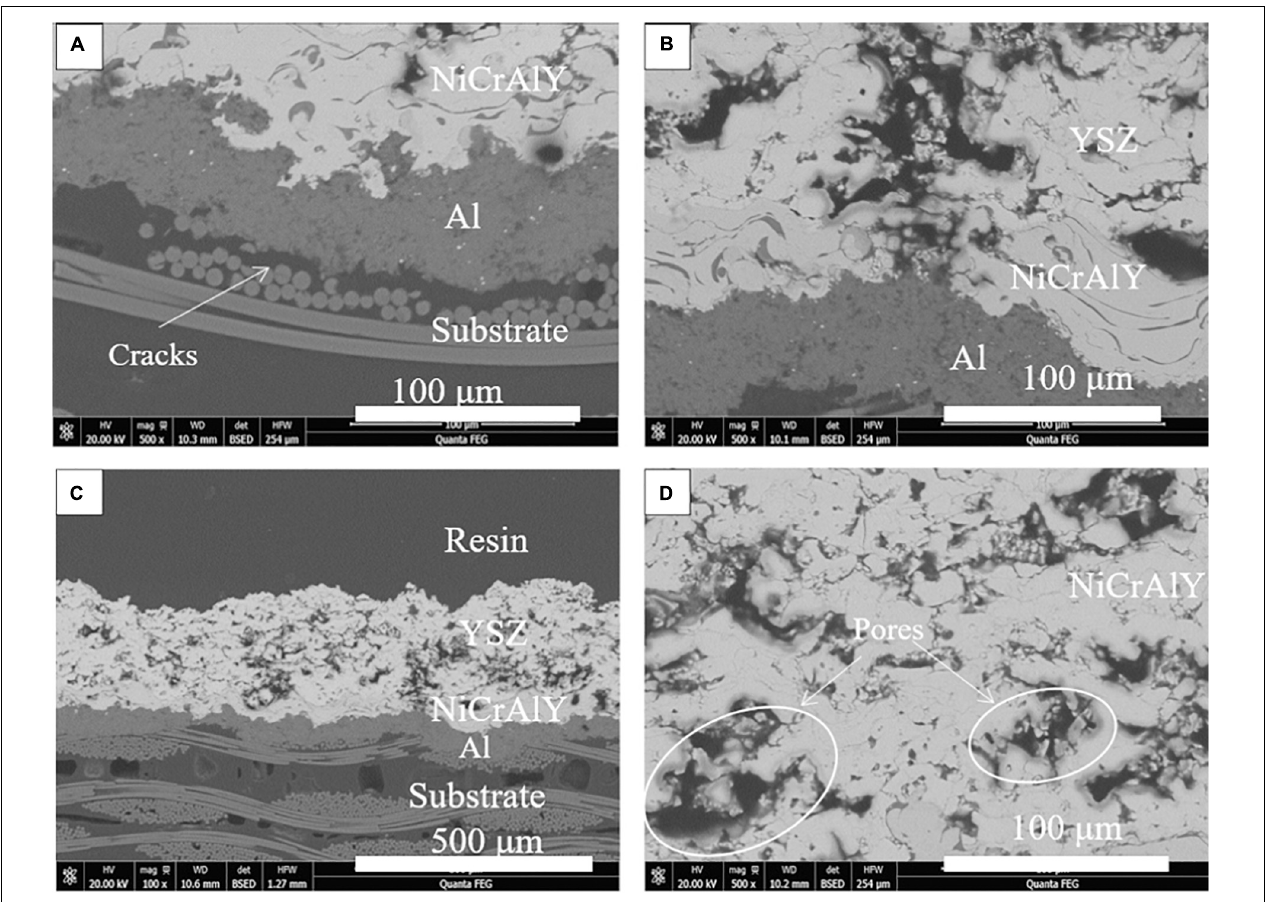
FIGURE 8 | The cross-sectional microstructures of coating A50N50Y200 after thermal ablation test: (A,B) ablation center region and (C,D) ablation rim